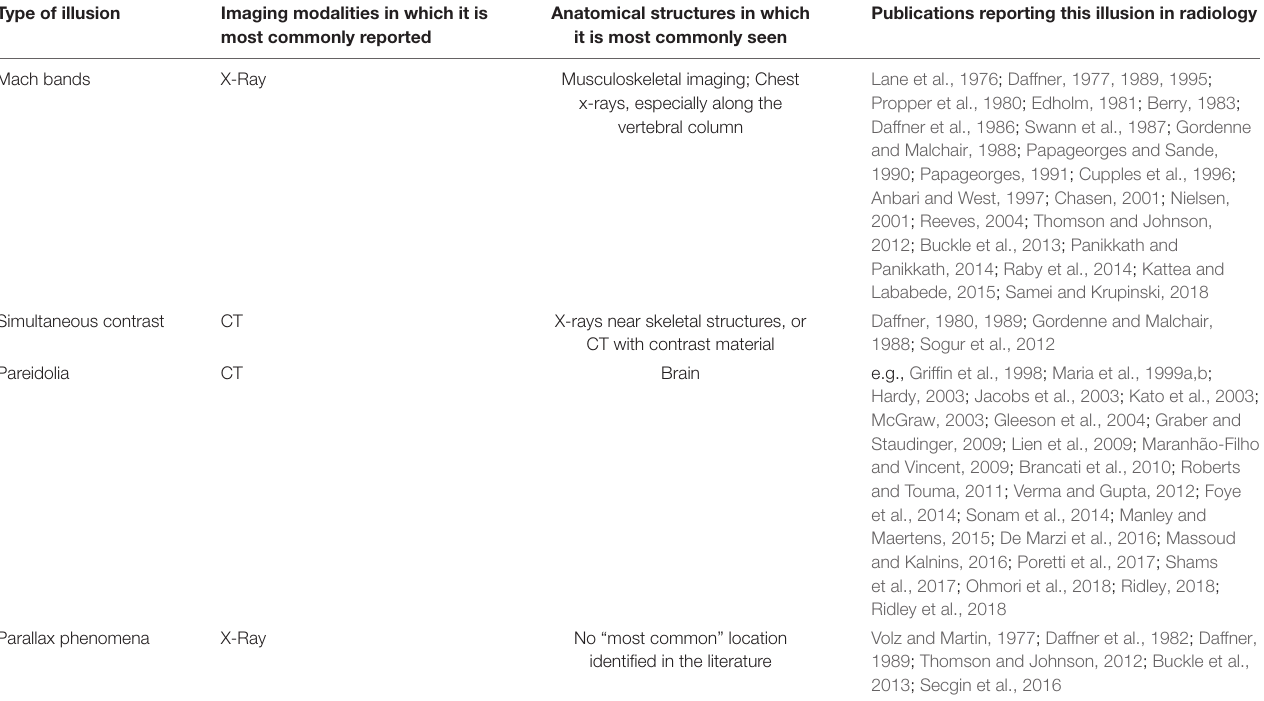
TABLE 1 | Common visual illusions observed in